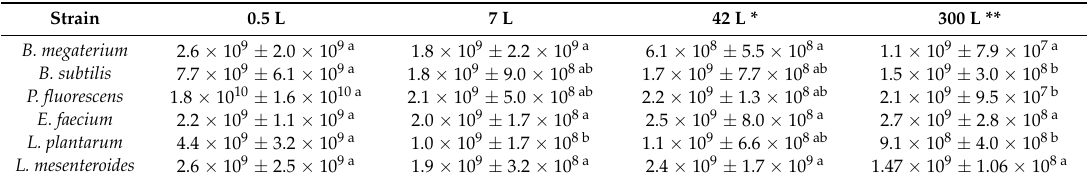
Table 4. The number of microorganisms (colony forming units, CFU/mL) during scaling up.